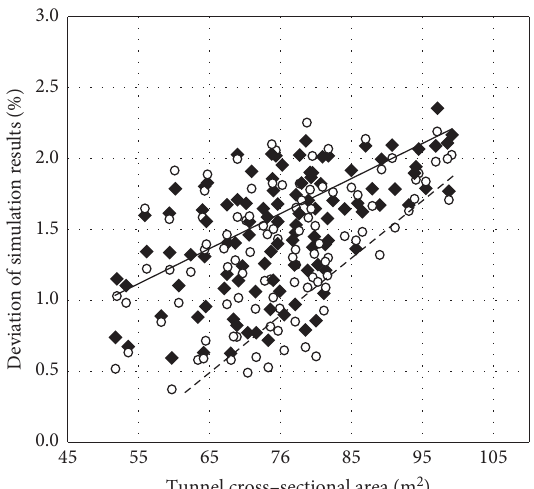
Figure 6: Linear regression relationship between simulation results and measured results (based on tunnel cross-sectional area) (data source: collected by the